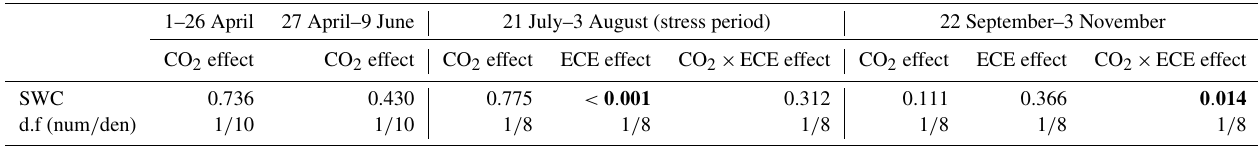
Table 1. Factor effects ( p values) on soil volumetric water content (SWC) at two levels of CO 2 concentration (390 and 520ppm) with or without an extreme climatic event (ECE).